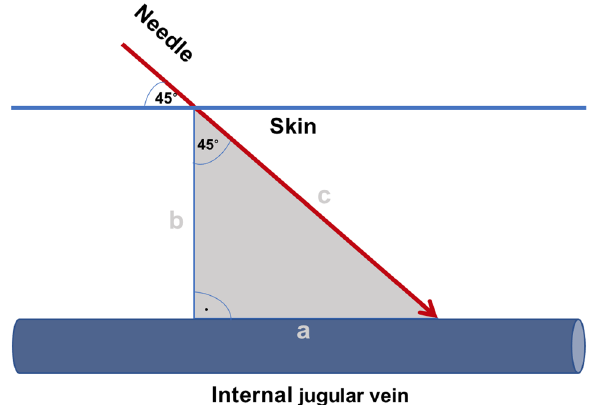
Figure 1. To calculate the minimum required Seldinger needle length to safely reach the middle of the lumen of the internal jugular vein, the ultrasound skin–vein distance and an insertion angel of the needle of 45° were used for the following calculation. Assuming an isosceles triangle the distance from skin to the internal jugular vein (b) at a 90° angle was measured by ultrasound. To calculate the distance from the skin to the internal jugular vein at a 45° angle (c) Pythagoras’ theorem (a 2 + b 2 = c 2 ) was applied.